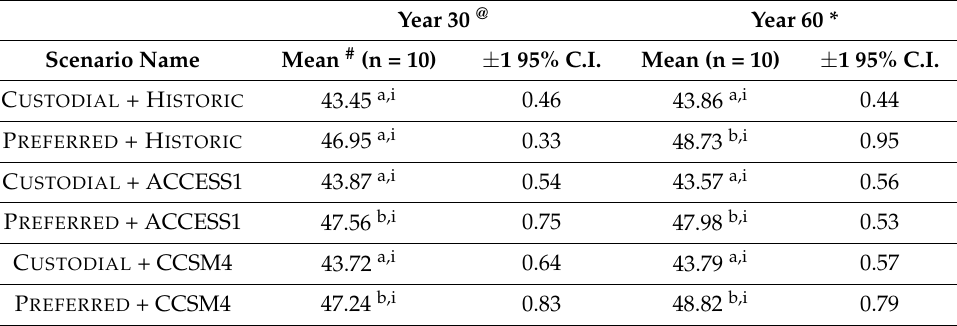
Table 8. Average habitat suitability for GSG in the Black Mountains. Habitat suitability scales from 0% to 100%. Average habitat suitability for year 0 of simulation was 50.5%. Difference between means was analyzed using a 2 × 3 factorial analysis of variance (ANOVA; 2 = management levels, 3 = climate levels). Degrees of freedom (df) for management, climate, interaction factors, and error, respectively, were (2 − 1) = 1, (3 − 1) = 2, (2 − 1) × (3 − 1) = 2, and 2 × 3 × (10 replicates − 1) =